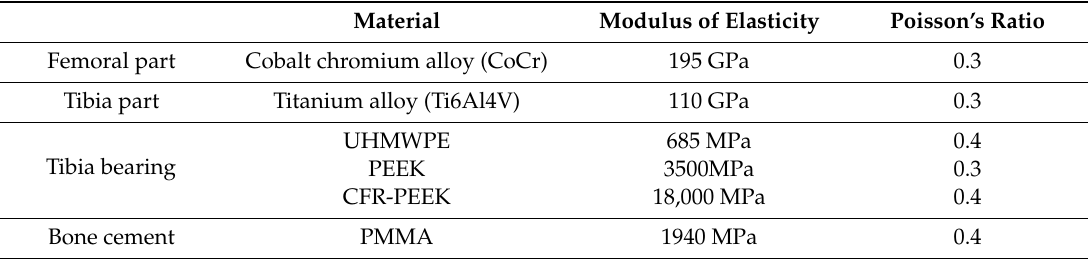
Table 1. Mechanical properties applied in FE